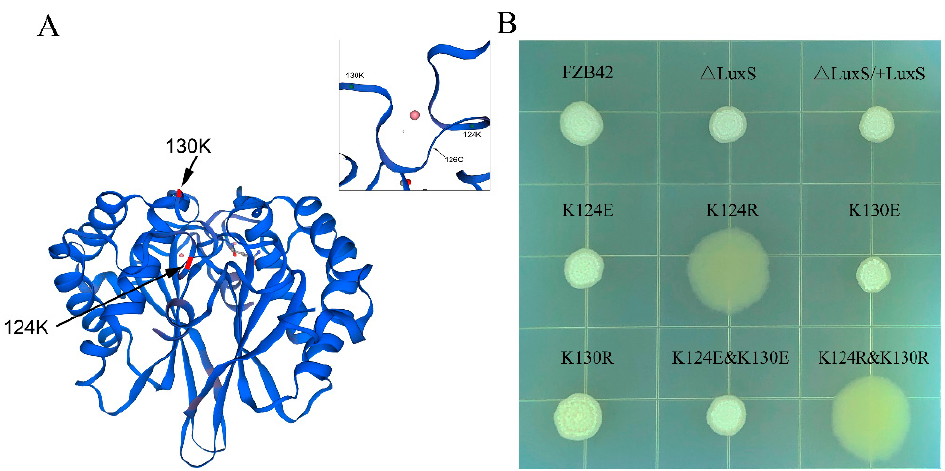
Figure 1. ( A ) Structure of LuxS of B. velezensis (FZB42) obtained by homology modeling with the web-based integrated service SWISS-MODEL [31]. ( B ) Colony morphology of FZB42 WT and its derived mutants grown on LBGM agar at 25 °C for 48 h.